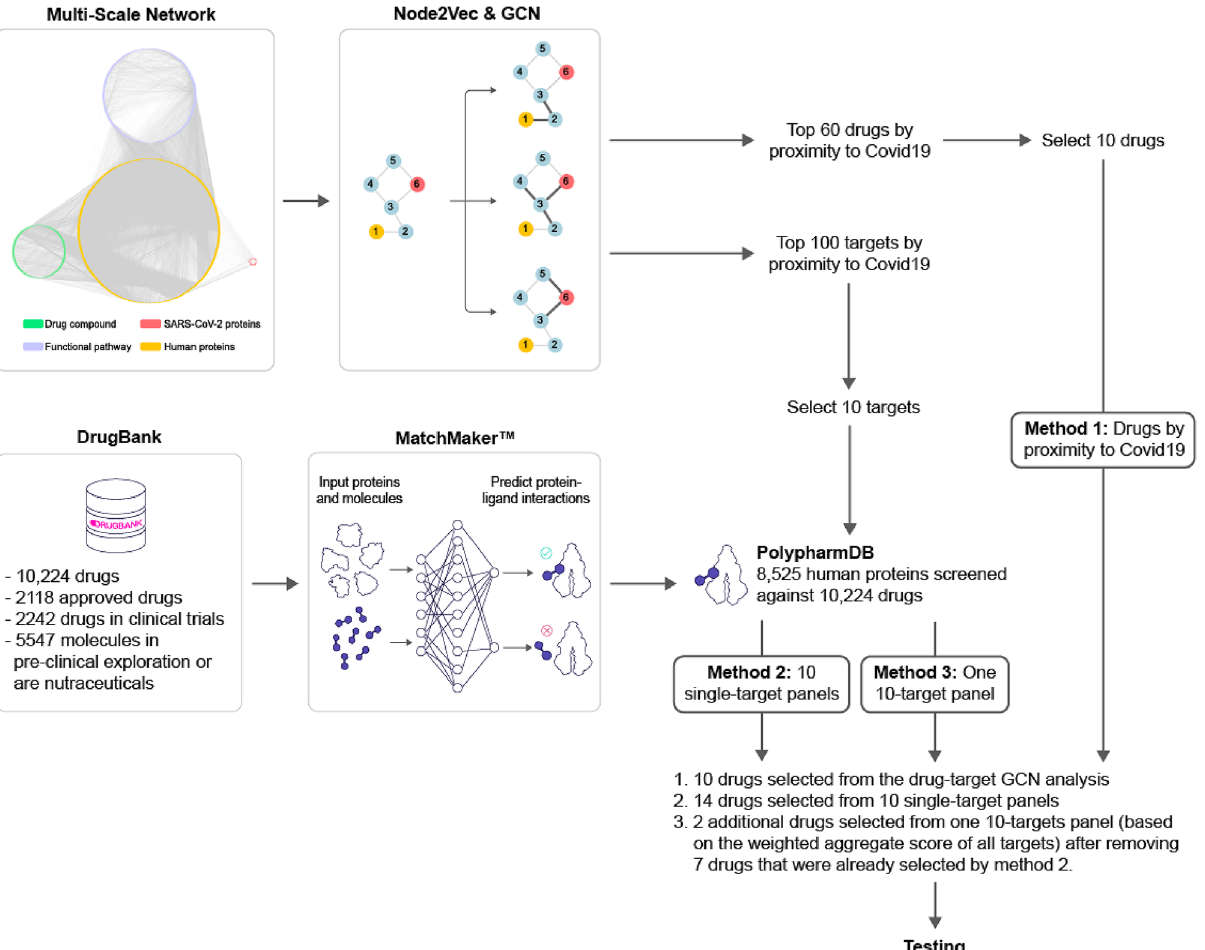
Figure 1. Three methods of selecting top drug candidates based on the GCN and MatchMaker prediction. Twenty-six drugs were selected for experimental testing by applying the predictions made by Node2Vec/GCN and MatchMaker models using three different methods. For Method 1 , ten drugs were selected directly from top 60 drugs that were predicted to be most proximal to COVID-19 based on the GCN alone. For Methods 2 and 3 , first, ten human protein targets were selected from the list of top 100 proteins that are most proximal to COVID-19 based on the GCN prediction. Following that, for Method 2 , 14 drug candidates were selected from top ten top ranking PolypharmDB (i.e., 10,224 drugs from DrugBank 95 screened against 8525 human proteins; see Materials and Methods ) candidates for each protein (i.e. ten single-target panels resulting in 100 candidates in total). For Method 3 , nine out of the top 25 ranking PolypharmDB candidates for the ten-targets panel